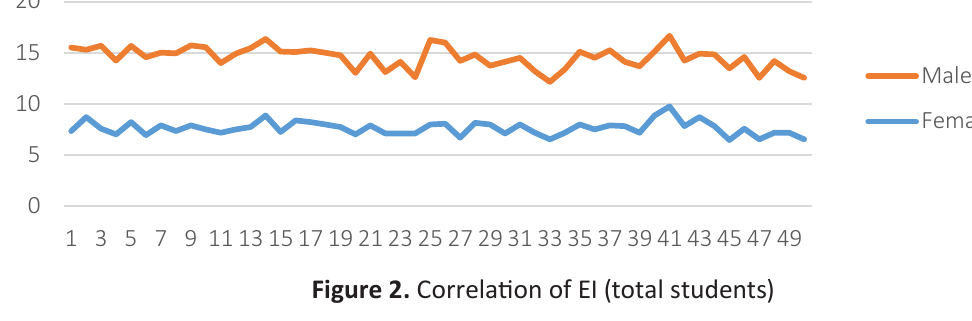
Figure 2. Correlation of EI (total students)